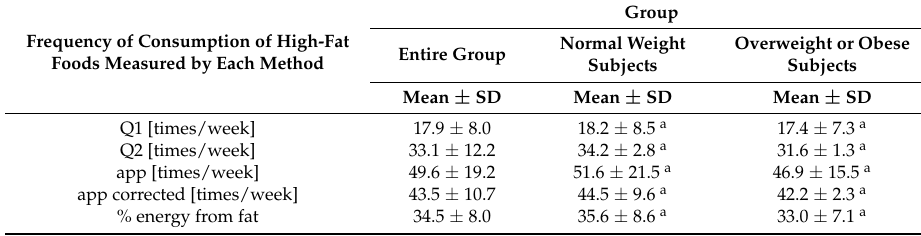
Table 2. Intake of high-fat foods measured with Q1, Q2 and the app and percentage energy from fat measured with dietary records. Data are presented as means with standard deviations. Group Frequency of Consumption of High-Fat Normal Weight Entire Group Foods Measured by Each Method